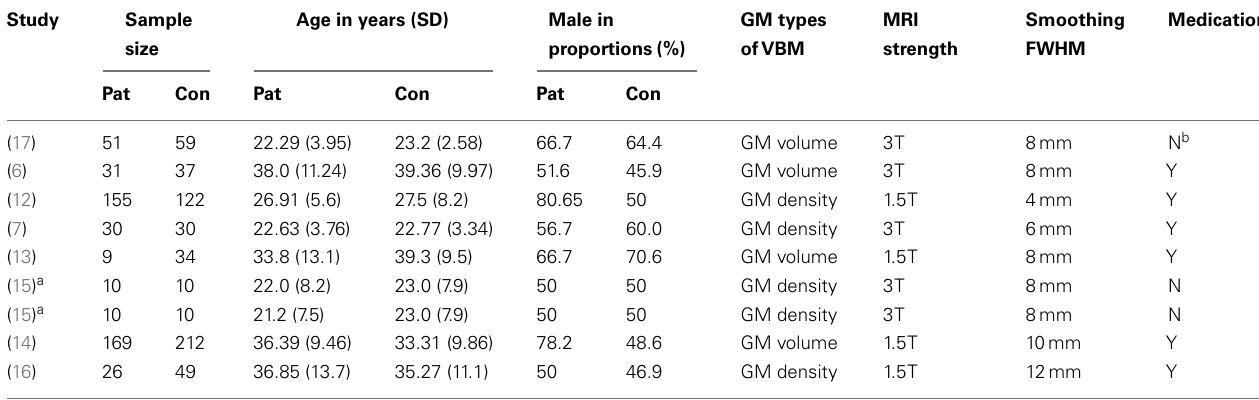
Table 1 | Demographic characteristics of the studies comparing schizophrenia patients and healthy controls .